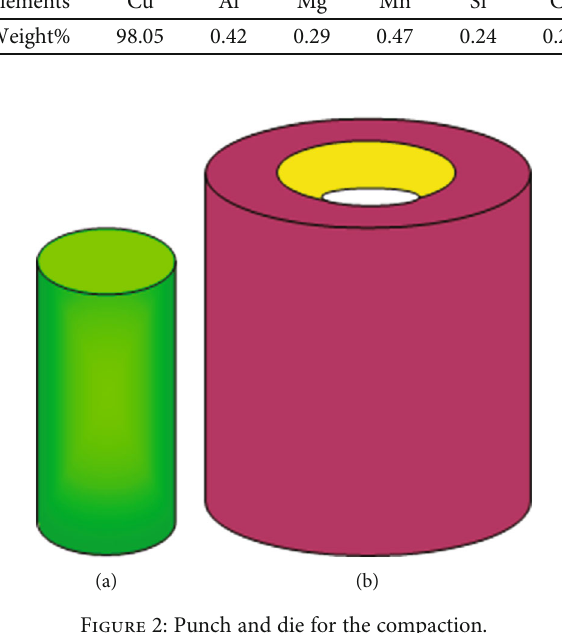
Figure 1: Flowchart of the proposed study.